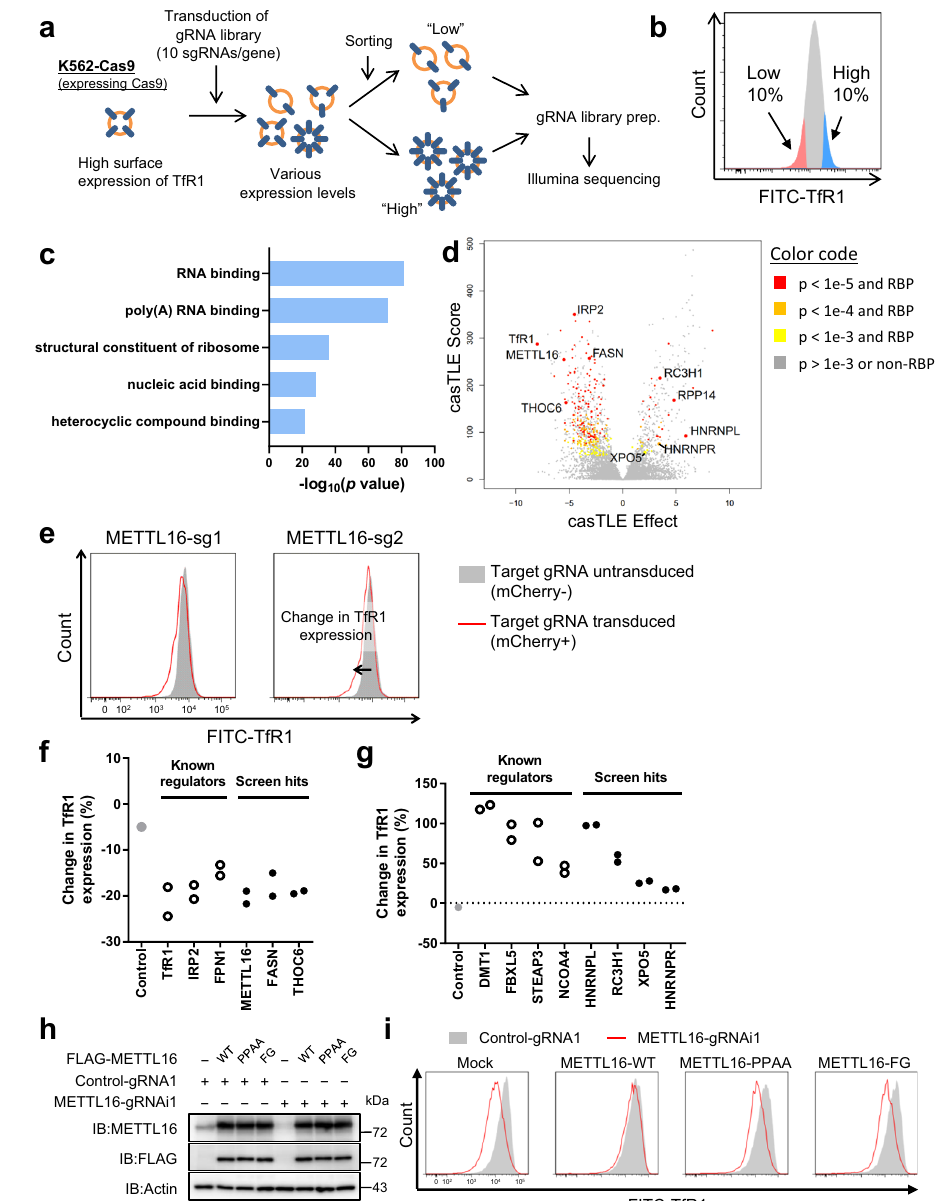
Fig. 1 | A genome-wide pooled CRISPR screen identi fi es novel RNA-binding proteins which regulate TfR1 expression. a , b Work fl ow ( a ) and cell sorting strategy ( b ) of the genome-wide CRISPR screen for TfR1 regulators. c Gene ontol- ogyanalysisoftheTfR1CRISPRscreenhits.Statisticalanalysiswasperformedusing Immuno-Navigator 83 . d Volcano plot of TfR1 phenotype (casTLE Effect, the most likely effect size as determined by casTLE) and the con fi dence in that effect size (casTLE Score) from the CRISPR screen. The screen was performed in duplicate. e – g Validation of the screen hits. Two gRNAs per gene were chosen for retests. K562-Cas9cellsweretransduced withlentiviralvectorsencoding individualgRNAs together with mCherry. Then cells were stained with anti-TfR1 antibody and